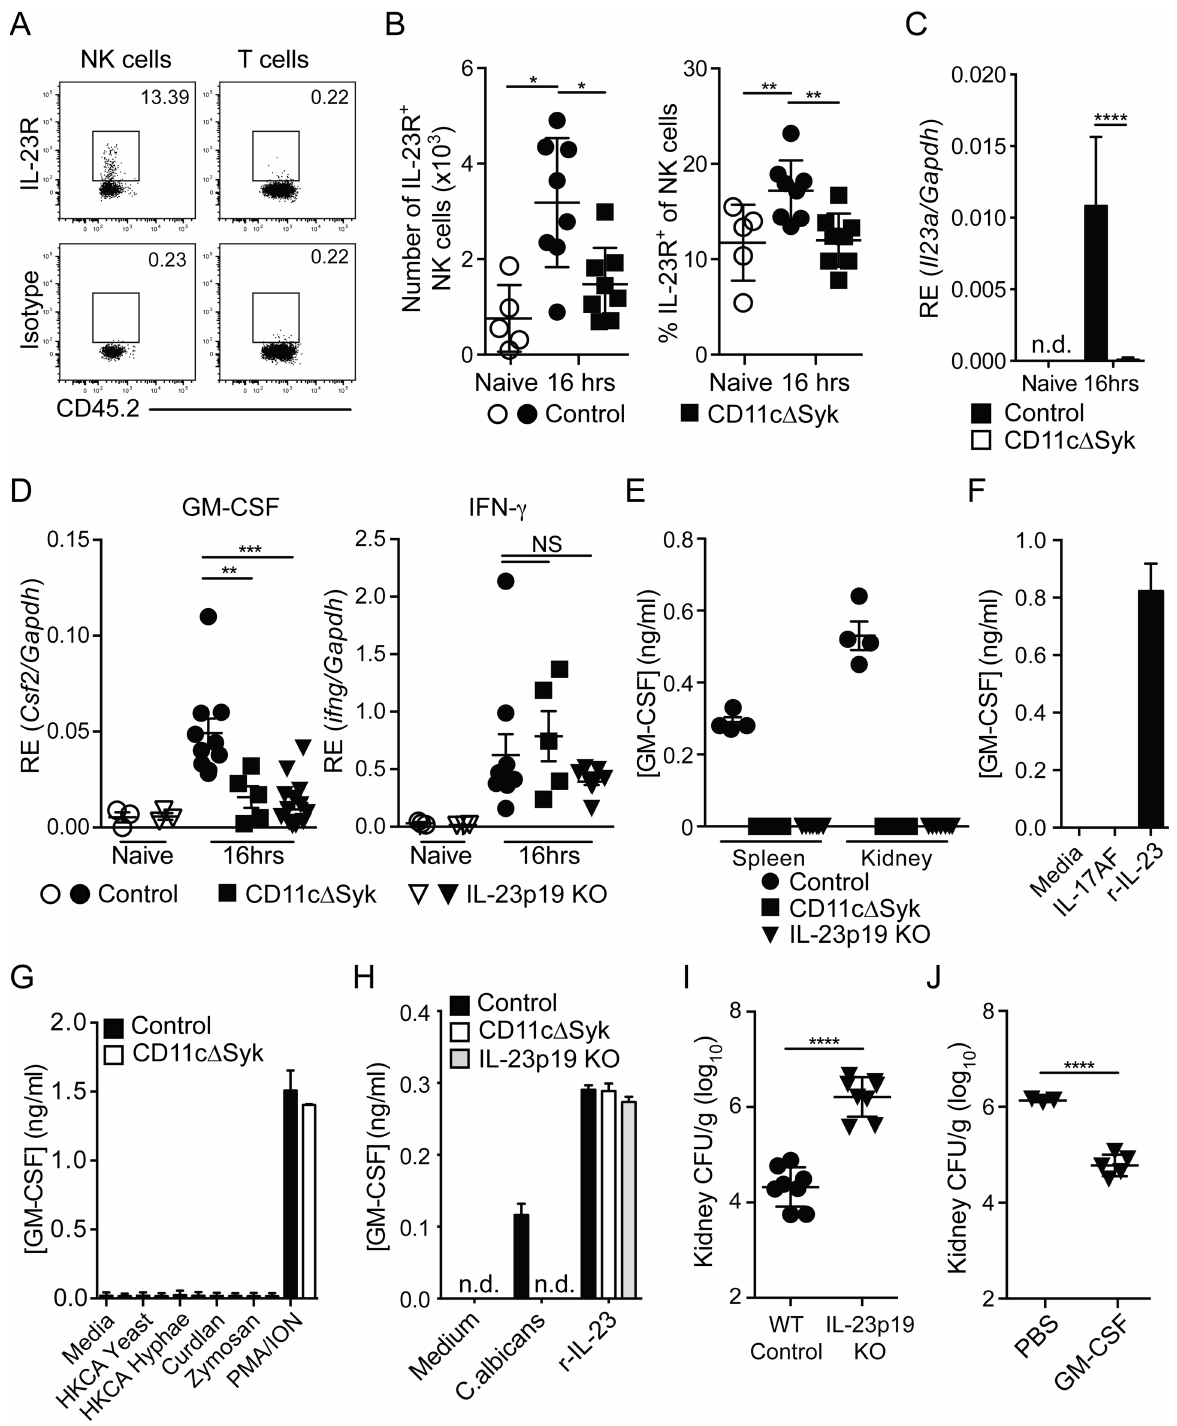
Fig 6. Defect in IL-23p19 production by Syk-deficient kidney DCs underlies decreased NK cell GM-CSF-mediated control of C . albicans . (A) Representative staining of na ï ve control kidney NK cells (CD45.2 + NK1.1 + CD3 − ) and T cells (CD45.2 + CD3 + ) with anti-IL-23R vs. isotype- matched irrelevant specificity control (B) Percentage and total number of kidney NK cells expressing IL-23R in control and CD11c Δ Syk mice that were either uninfected or infected 16 h earlier. Data are mean +/ − SEM from three independent experiments with each symbol representing an individual mouse. (C) CD11c + MHC-II + cells were purified by cell sorting from the kidneys of na ï ve or 16 h post-infection control and CD11c Δ Syk mice. RNA was extracted and qRT-PCR performed to detect il23a transcripts . Data shown are mean +/ − SEM from two independent